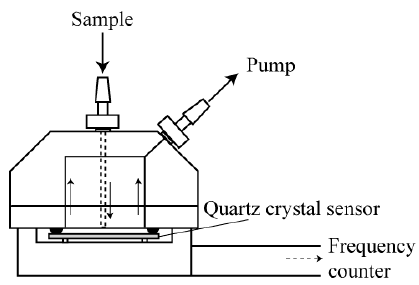
Figure 1. Schematic of the flow cell equipped with quartz crystal sensor. Solid-line arrows indicate travel directions of